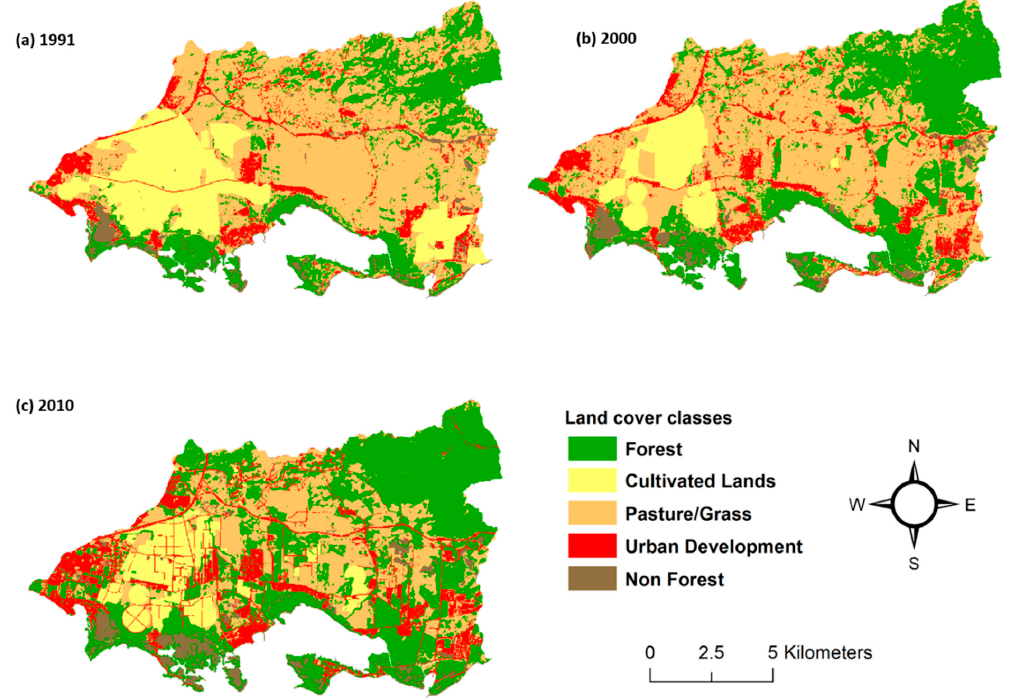
Figure 3. Land use/cover maps based on the classification system made by Kennaway and Helmer (2007) in 1991, 2000, and 2010.